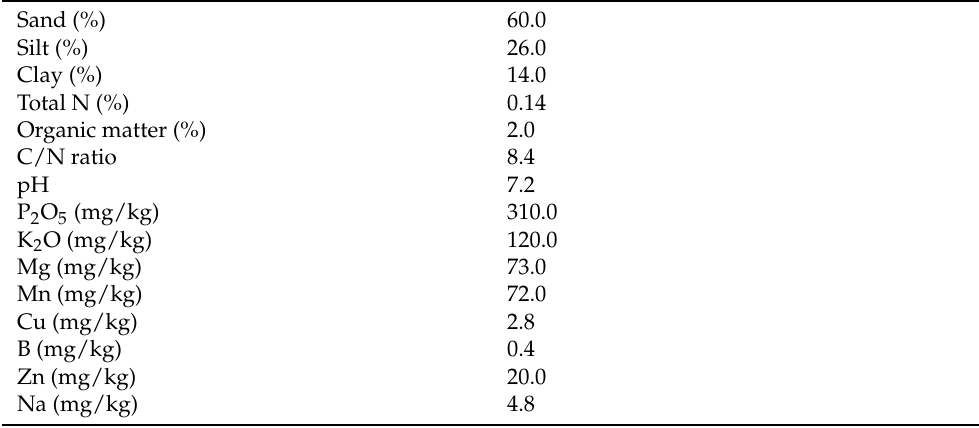
Table A1. Physical and chemical constitutions of the soil used for the